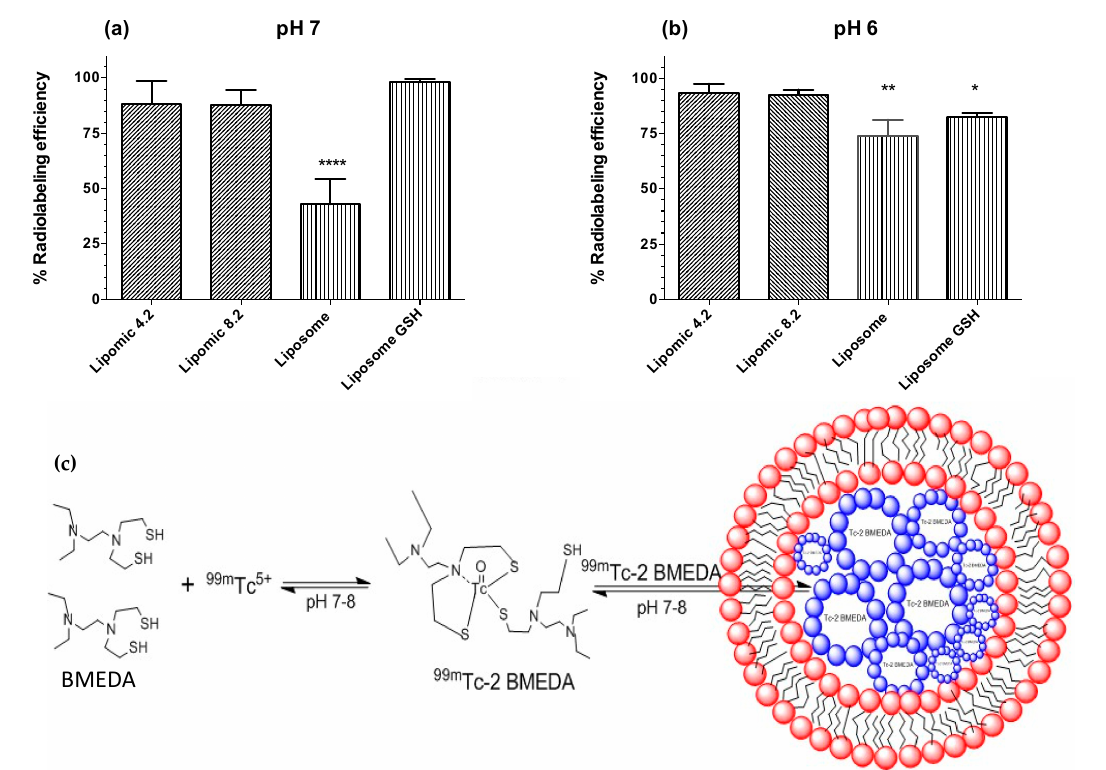
Figure 6. Radiolabeling efficiency of lipomics and liposomes as a function of pH to compare the encapsulation efficiency of lipophilic and hydrophilic molecules. ( a ) In lipophilic conditions (pH 7), (****) is statistically different from Lipomics 4.2 and 8.2, and liposome GSH. ( b ) In hydrophilic conditions (pH 6), (*) and (**) are statistically different from Lipomics 4.2 and 8.2. ( c ) The figure illustrates the encapsulation of lipophilic molecules (i.e., 99m Tc-2 BMEDA) in the micelles (blue structures in the figure) contained by lipomics.